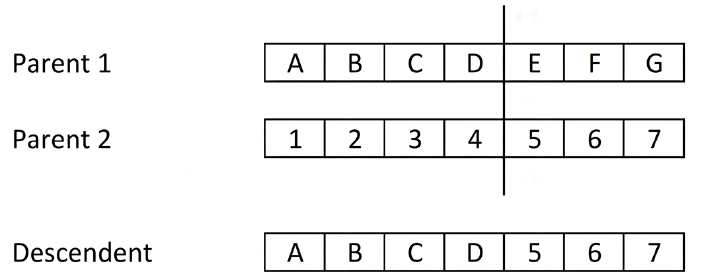
Figure 18. Example of the crossover operation with single point cutting in a genetic algorithm. Each chromosome is fragmented into two parts and the offspring receives one fragment from each parent.